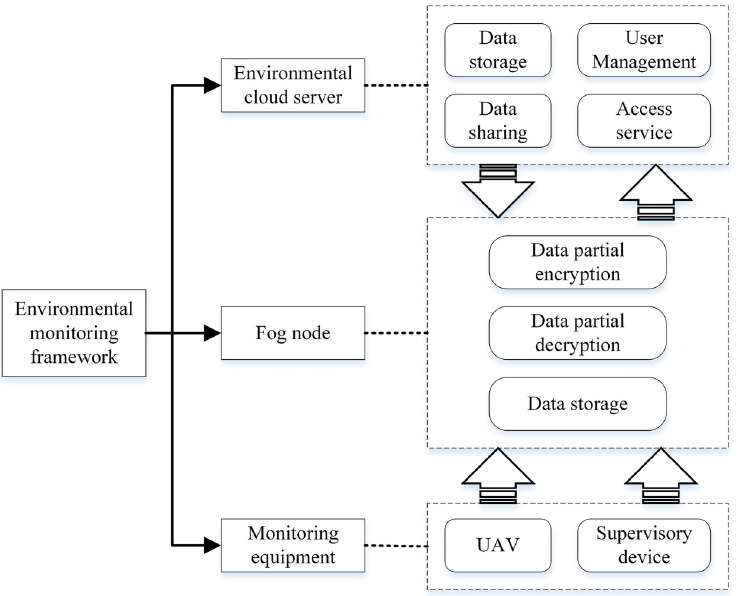
Fig 1. A three-layer framework of environmental